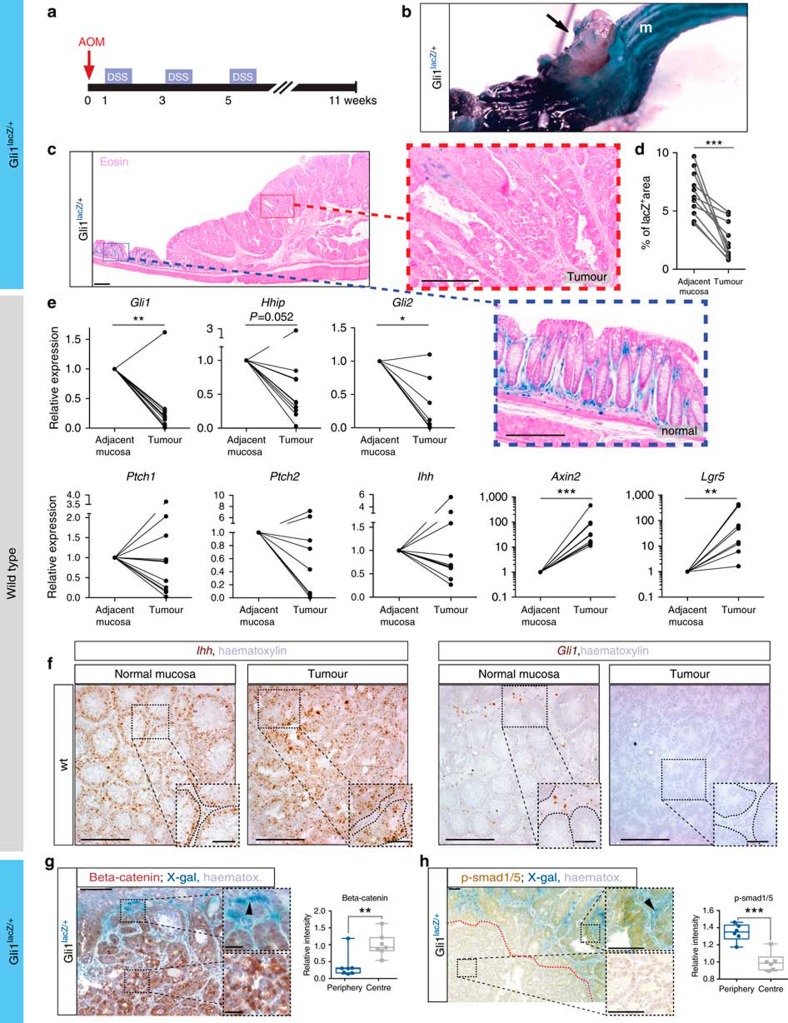
Reduced stromal Hh activity in AOM/DSS-induced colon tumours.(a) Schematic of the AOM/DSS protocol. (b) Representative example of an X-gal-stained tumour in a Gli1lacZ/+ mouse (from >20 tumours in 11 mice). Arrow indicates the tumour; r, rectum; m, normal mucosa. (c) Microscopic appearance of an AOM/DSS-induced tumour in a Gli1lacZ/+ mouse after X-gal staining (representative of n=11 tumours from n=9 mice). Magnifications of normal mucosa: blue box and neoplastic tissue: red box; scale bars, 100/50 μm. (d) Quantification of X-gal-positive area in tumour and adjacent mucosa (P=0.0002; paired t-test). (e) Real-time quantitative PCR (RT-qPCR) for the indicated transcripts from tumours and matched normal mucosa, statistics from paired t-tests based on the ΔCT values with multiple test correction (fdr, Benjamini and Hochberg): P=0.003 (Gli1), P=0.052 (Hhip), P=0.0232 (Gli2), P=0.199 (Ptch1), P=0.314 (Ptch2), P=0.771 (Ihh), P<0.0001 (Axin2) and P=0.0016 (Lgr5); n=11 tumours and adjacent mucosa from 11 wt mice; at least 8 matched pairs analysed for each transcript. (f) RNA ISH for Ihh and Gli1 on consecutive sections of the same tumour/mucosa sample; scale bars, 50/10 μm; dashed lines in magnified sections denote epithelial compartment. (g) IHC of β-catenin in an X-gal-stained Gli1lacZ/+ tumour indicating mutual exclusivity of epithelial Wnt activation and stromal Gli1; scale bars, 500/50 μm. The graph compares the relative staining intensity of the DAB chromophore at the tumour periphery and centre (n=7 tumours, P=0.006; box plots; whiskers represent minima and maxima). Arrowhead points to area of positive X-gal staining. (h) IHC of p-Smads1/5 in a tumour from a Gli1lacZ/+ mouse. Scale bars, 100 μm. Quantification of DAB intensity shows an increase at the periphery, in parallel to stromal Gli1 (n=6 tumours, P=0.0002; unpaired t-tests in f and g); data presented as box-and-whisker plots, whiskers represent minima and maxima. Arrowheads point to cells with positive X-gal staining indicating Gli1 expression. *P<0.05, **P<0.01 and ***P<0.001.